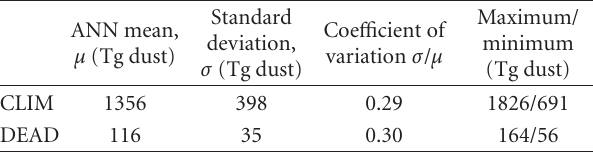
Table 3: Annual (ANN) mean dust deposition into the North Atlantic for the region shown in Figures 5(a) and 6. Also included are the standard deviation, the coe ffi cient of variation and the maximum and minimum deposition amounts of all modelled years.